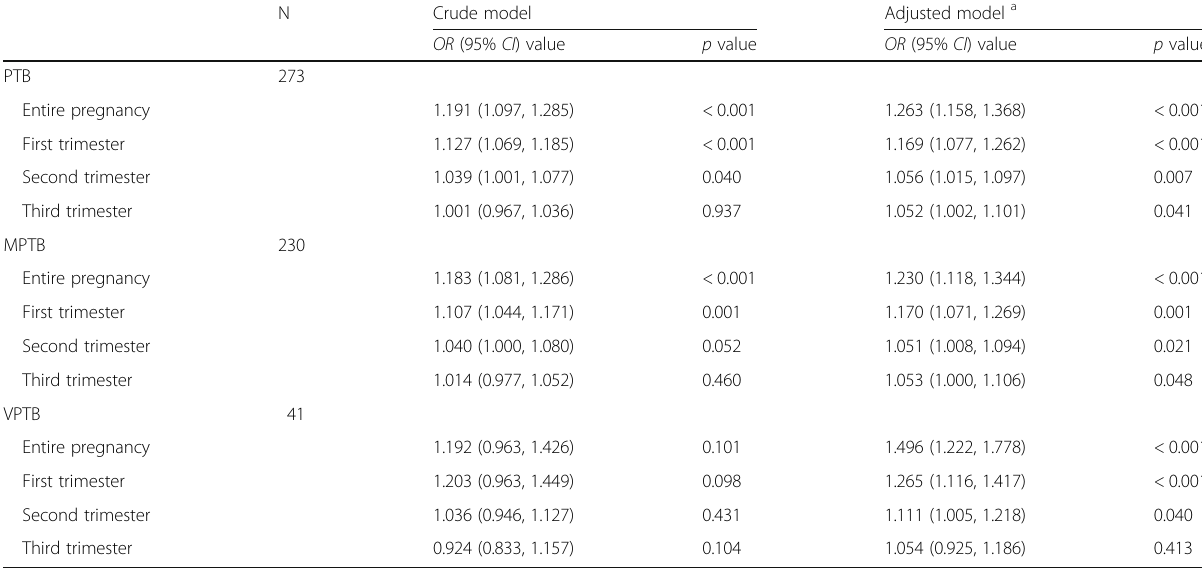
Table 3 Odd Ratios and 95% CI s of categorial PTB for per 10 μ g/m 3 increase in PM 2.5 during each time window based on LUR model estimates N Crude model Adjusted model a OR (95% CI ) value p value OR (95% CI ) value p